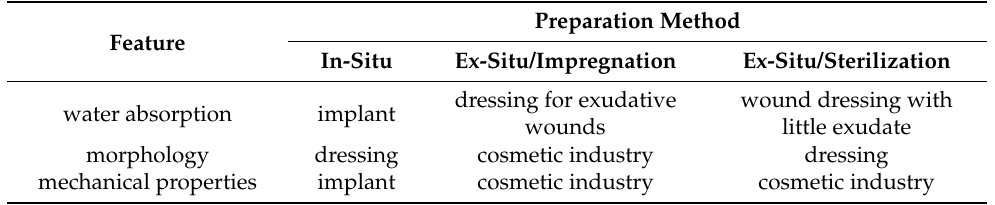
Table 7. Proposed application of the composites depending on the preparation method and the composite